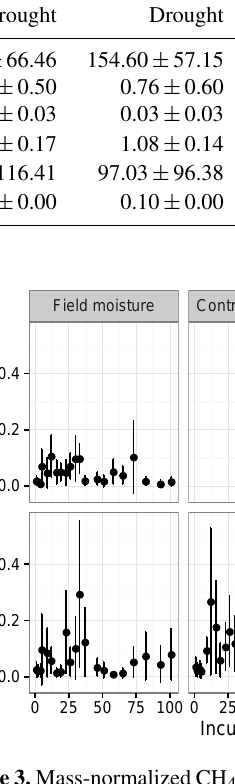
Figure 3. Mass-normalized CH 4 fluxes over the 100-day incubation by temperature (4 and 20 ◦ C, rows) and treatment (field moisture, drought, and controlled drought; columns). Error bars show core-to- core standard deviation. The controlled drought treatment, for 20 ◦ C only, was meant to dry cores at roughly the same rate as the drought cores at 4 ◦